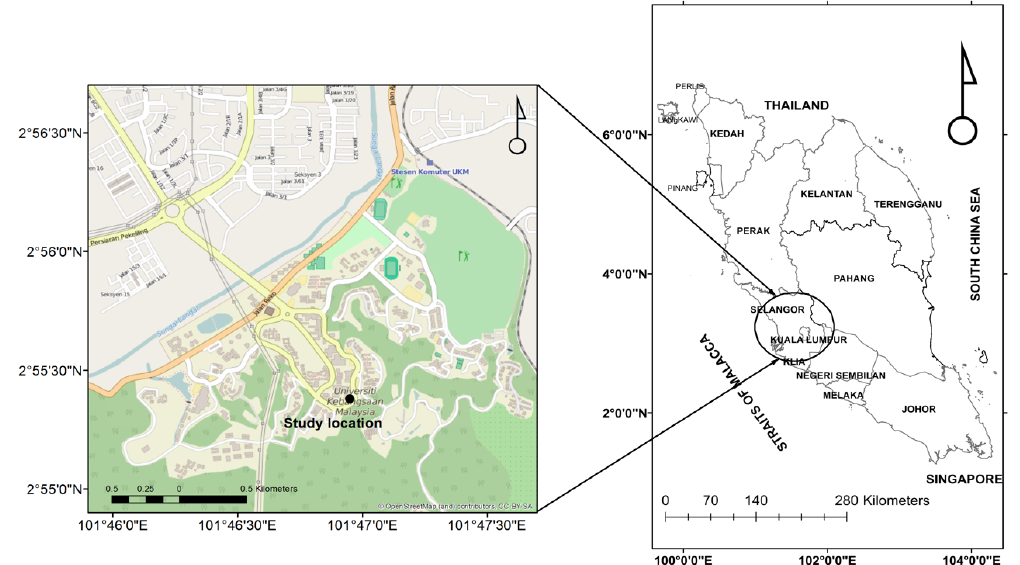
Figure 1. Map of the study area showing the sampling site and nearby line